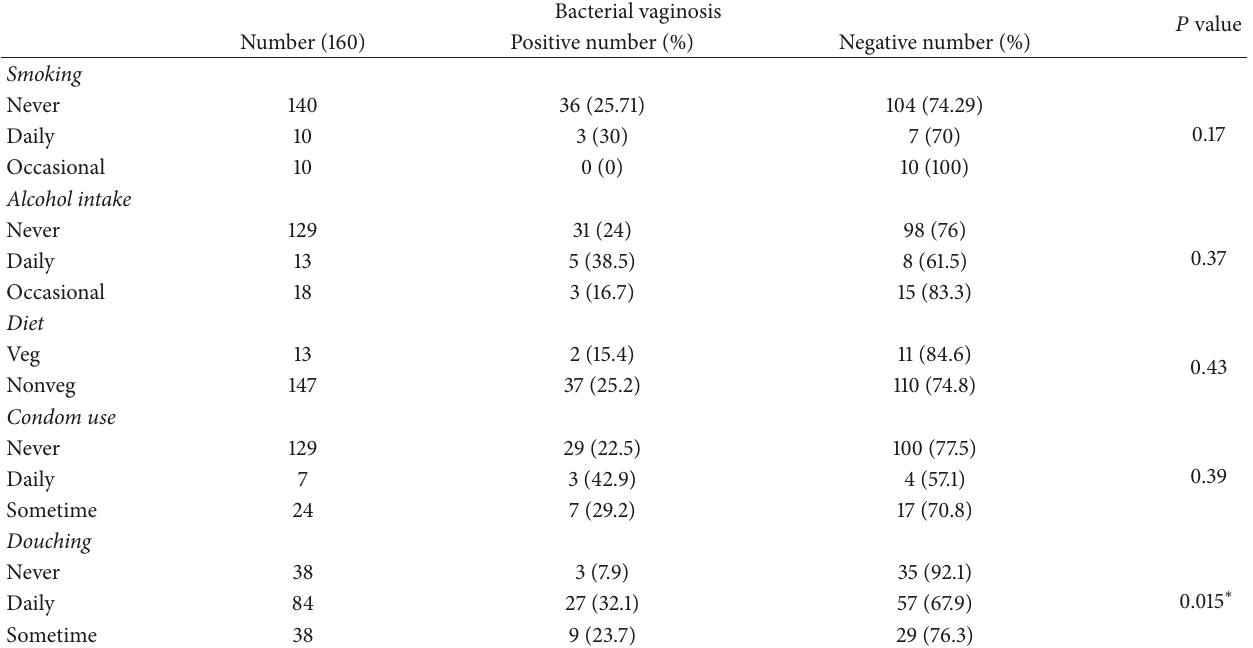
Table 3: Distribution of cases according to behavior characteristics.